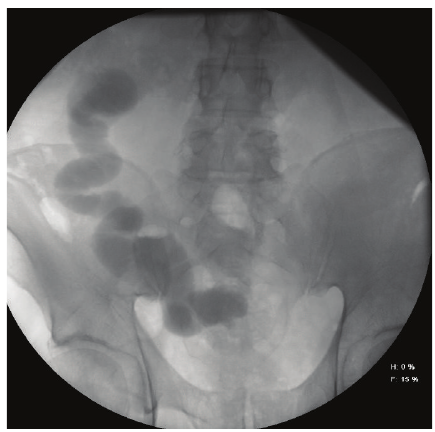
Figure 4: Voiding cystoureterogram.